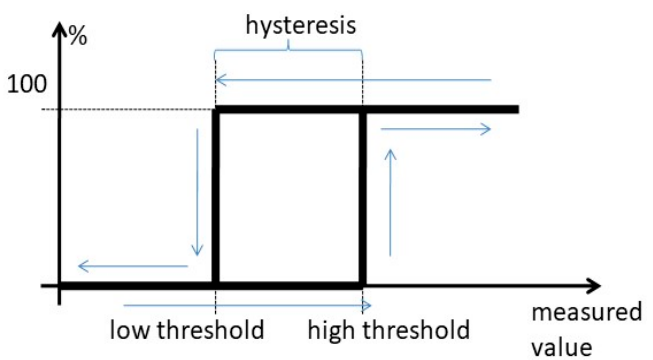
Figure 3. Using hysteresis to eliminate false detection.